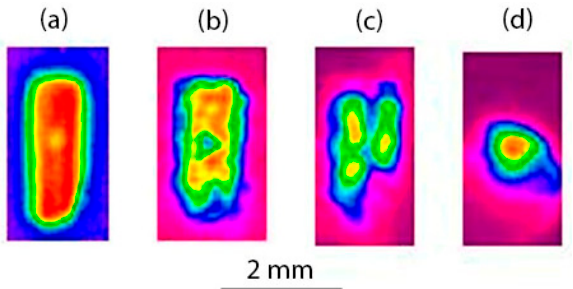
Figure 13. Profiler images of the fluorescence of UV-to-green converter placed at a distance of 100 mm ( a ) behind the lens focus and outlets of the through-channels of various lengths ( b ) 4.8, ( c ) 6.5 and ( d ) 23 mm. Pulse energy is ~15 mJ.